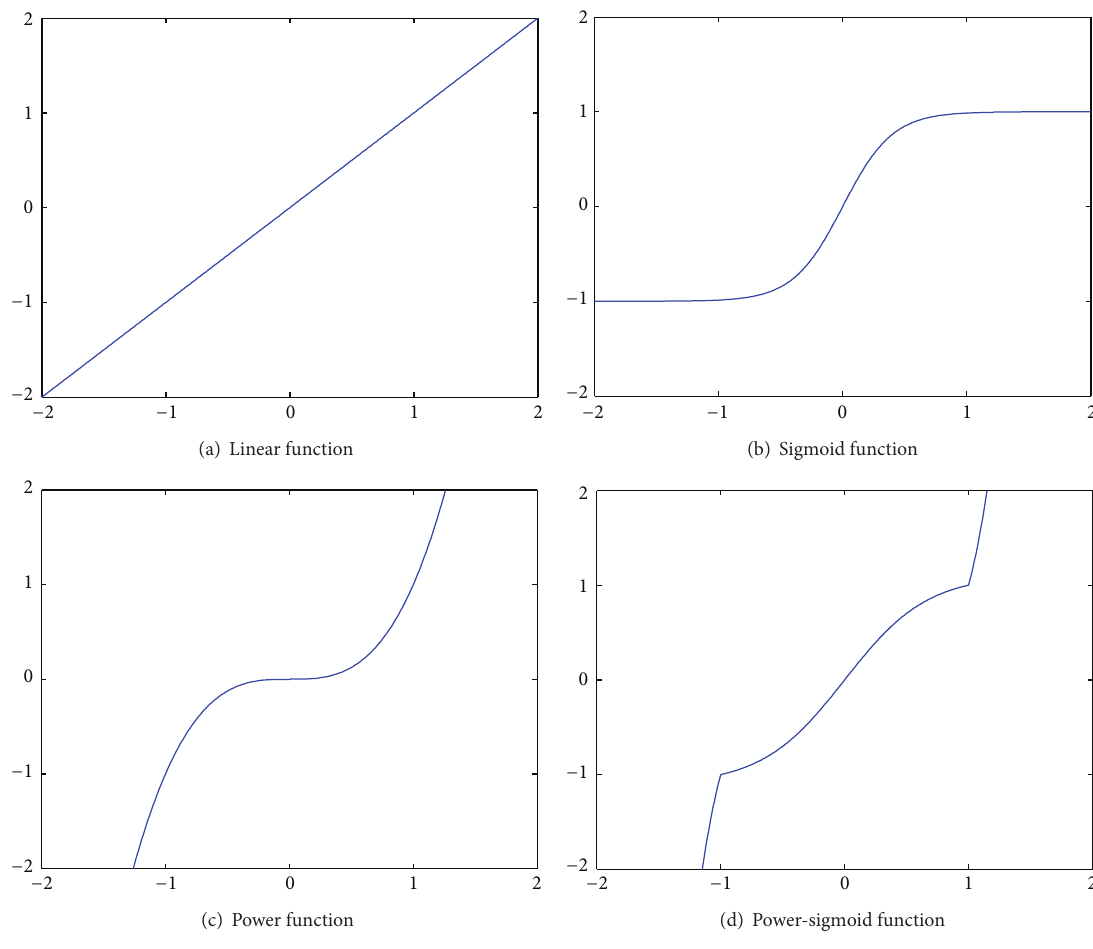
Figure 1: Behavior of the four basic activation